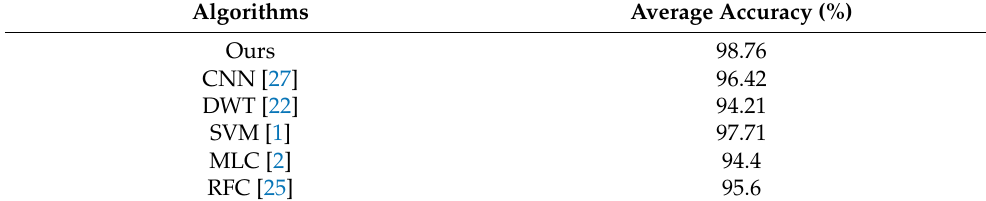
Table 11. Comparative analysis of the proposed Vision Transformer model with other algorithms for the area of Javadi Hills, India.